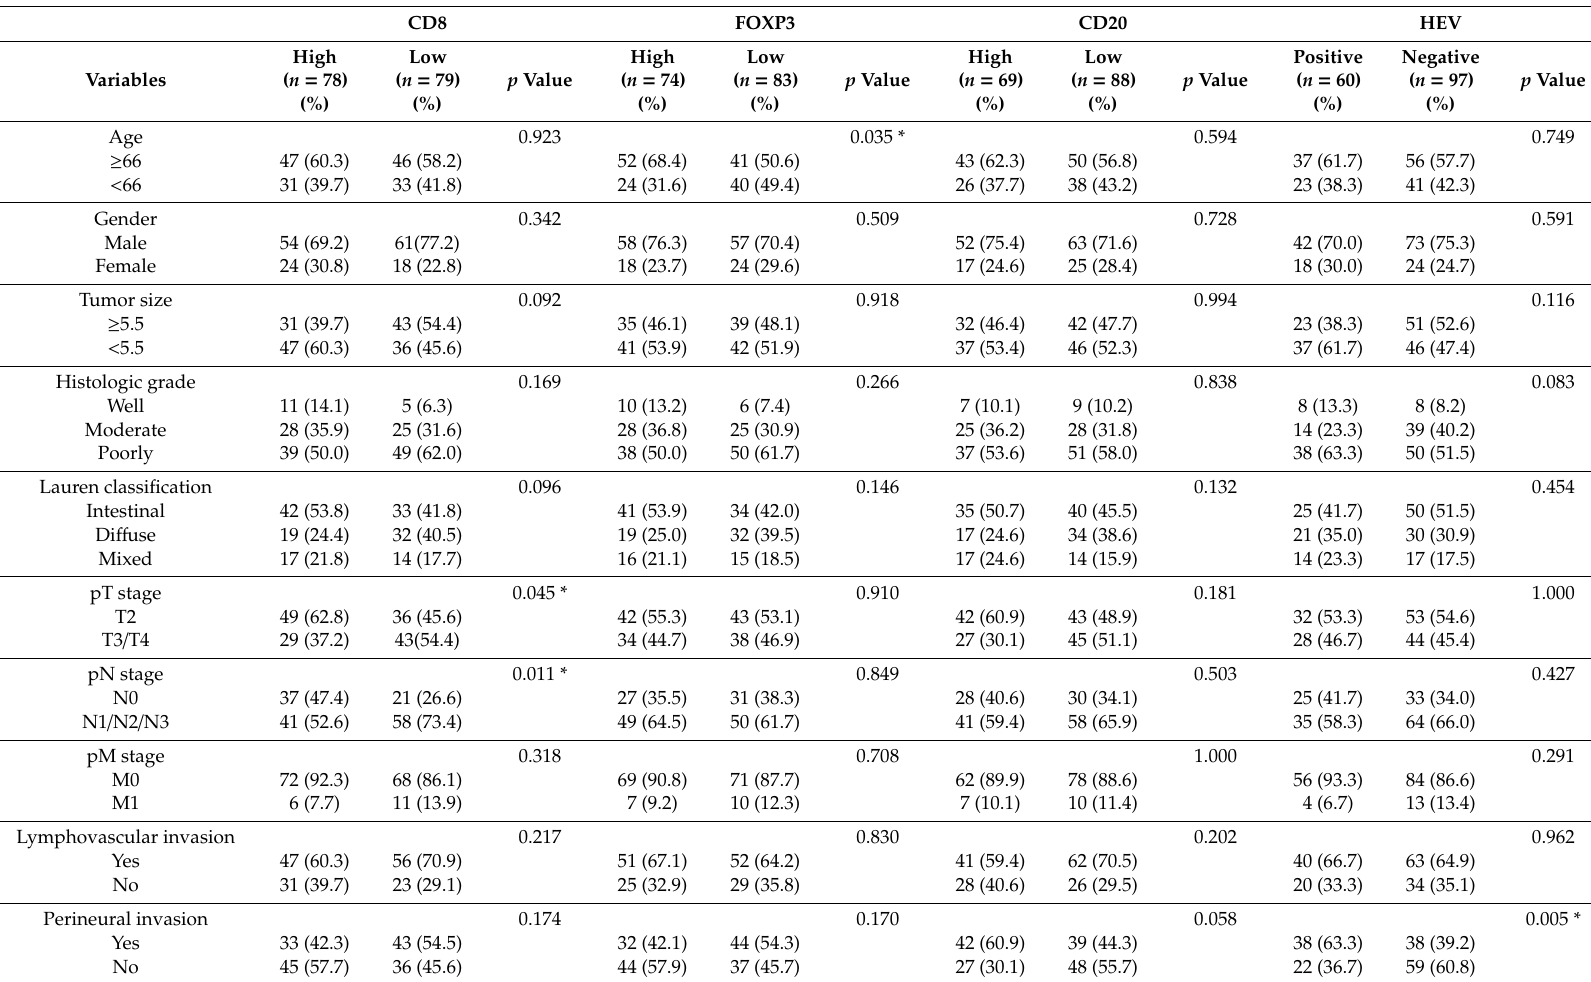
Table 1. The correlation of clinicopathologic findings of advanced gastric cancer with tumor-infiltrating lymphocytes and